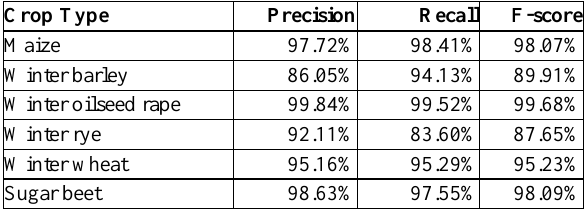
Table 5. Crop based classification performance for DL with SSL pretraining under temporal and spatial